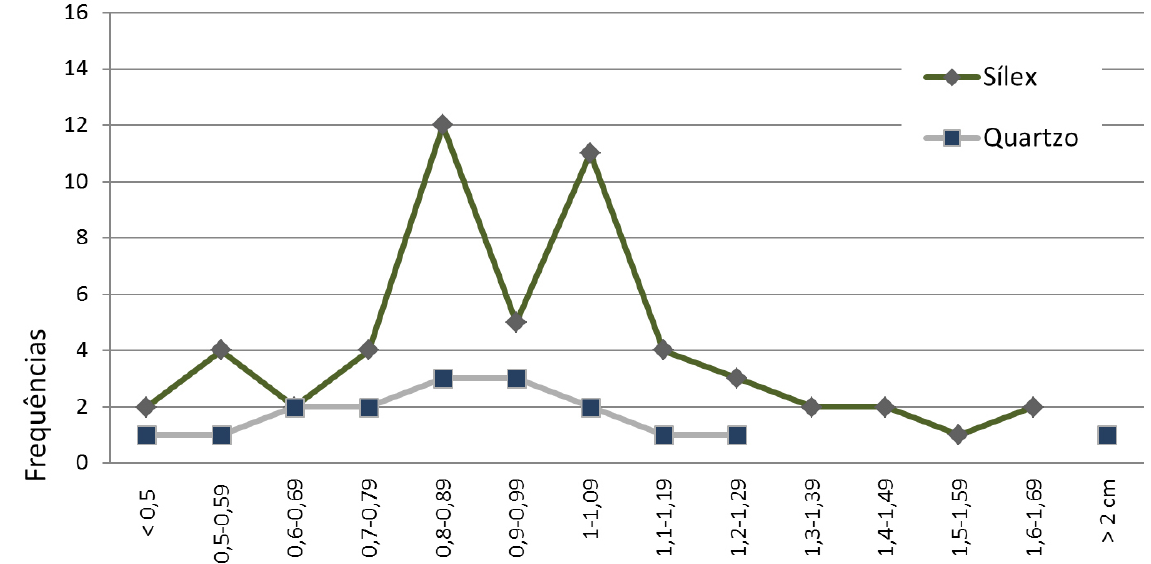
Figura 6. Variação das larguras (em cm) dos produtos alongados em bruto. Figure 6. Width variation (in cm) of the unretouched blades and bladelets.